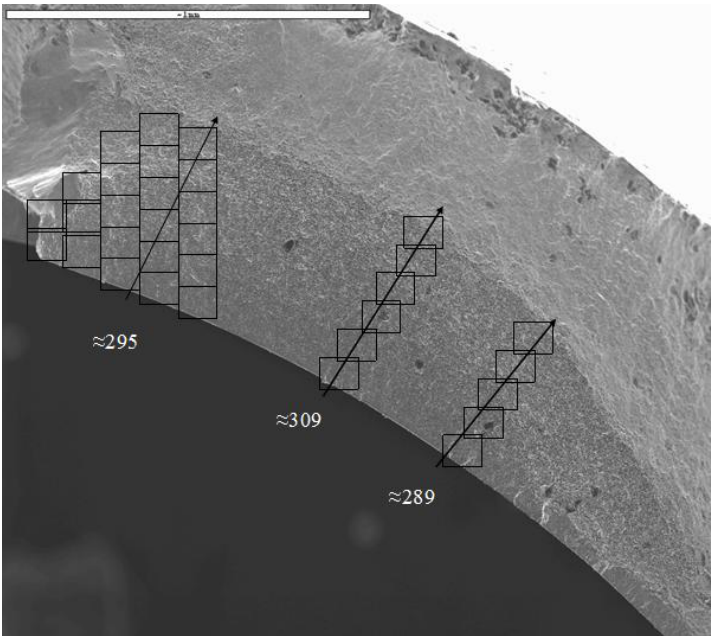
Figure 9. Fracture surface of RR1000 from an OOP180° anti-clockwise test (TMF013), with ∆ε = 1.4% resulting in a life of N mech